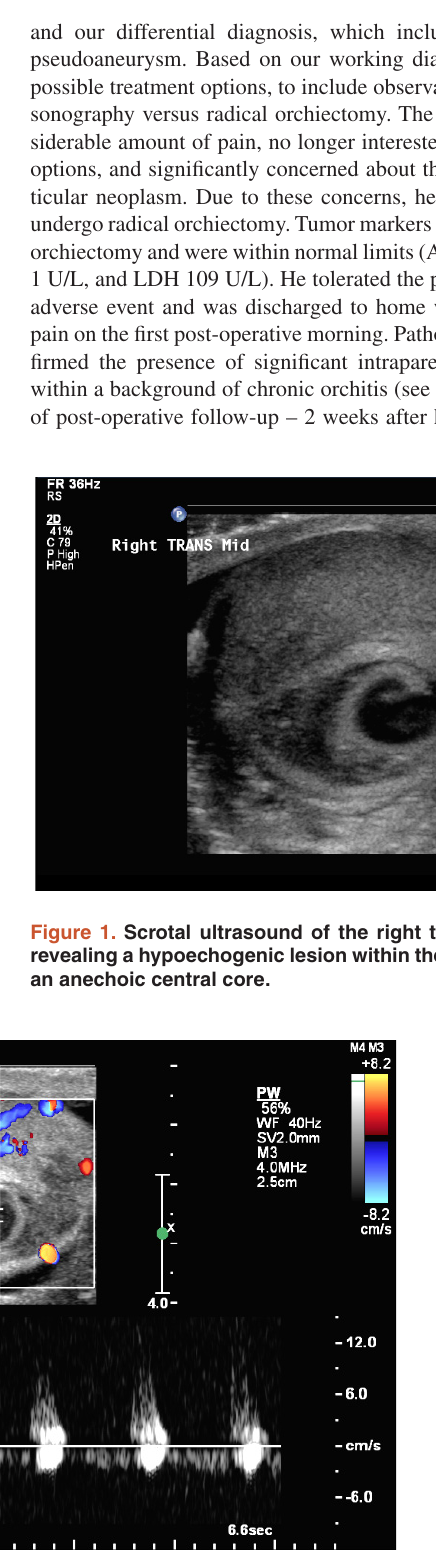
Figure 2. Doppler ultrasound of the right testicle in transverse reveals an arterial waveform within the center of the anechoic portion of the testicular